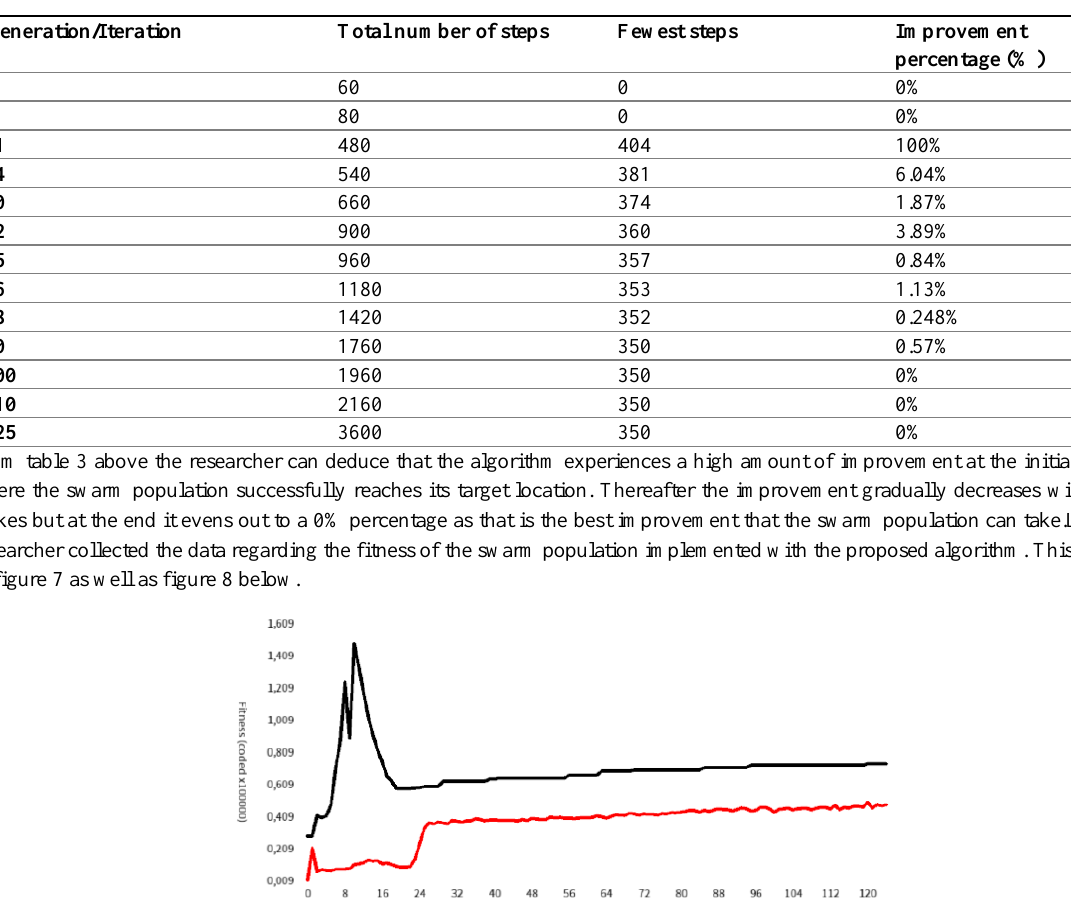
Table 3: Table representing the improvement % of the swarm population.